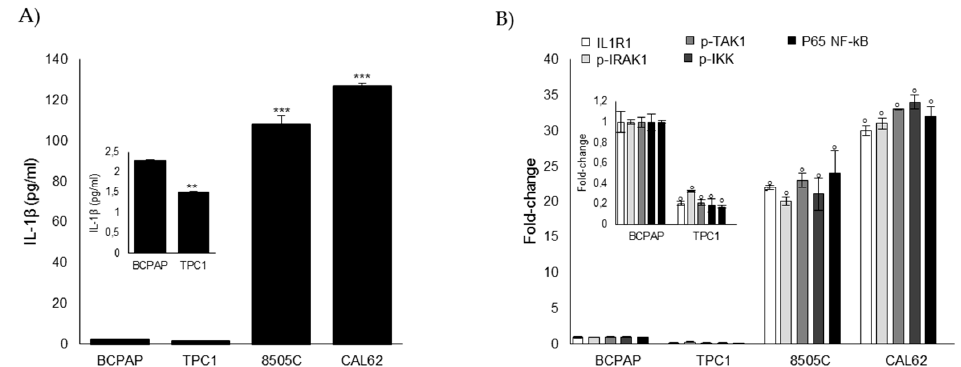
Figure 7. IL-1 β signaling in human TC cell lines. PTC (BCPAP and TPC1) and ATC (8505C and CAL62) cell models grown to confluence under standard conditions were analyzed by specific ELISA kits, following the manufacturer’s instructions, to evaluate ( A ) the secreted levels of IL-1 β (measured in the medium) and ( B ) levels of IL1 receptor, type I (ILR1) (measured in the cell lysates), phospho-IRAK-1 (p-IRAK1) (a cell-based method), phospho-TAK1 (p-TAK1) (measured in the cell lysates), phospho-IKK (p-IKK) (a cell-based method), and P65 NF-kB (measured in the nuclear extracts). The histograms indicate mean ± SD of three different cultures, and each was tested in triplicate. The inserts represent the original histograms without ATC cells in order to better appreciate changes in PTC cells. ** p < 0.01, *** p < 0.001, and ° p < 0.001.